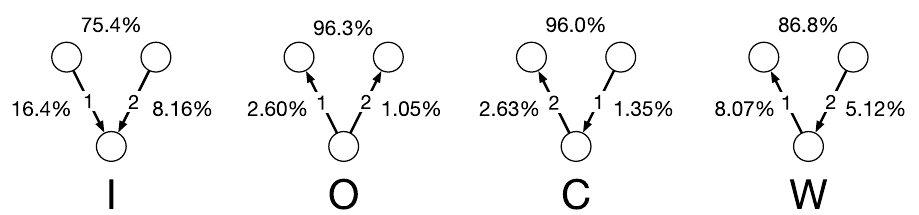
Figure 7. Fractions of the node pairs between which the collaborations occur in 3-node 2-event opposition